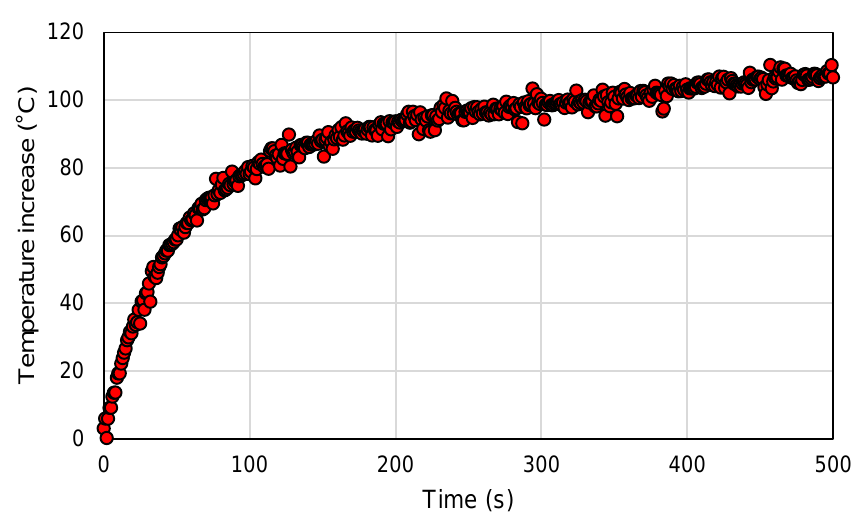
Figure 4. Temperature gain of the exiting air over the course of a test for heater model A at full output.